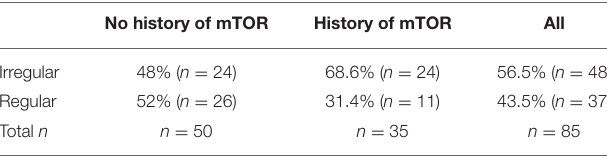
TABLE 3 | Frequency of menstrual irregularities in respondents with and without a history of mTORi use.